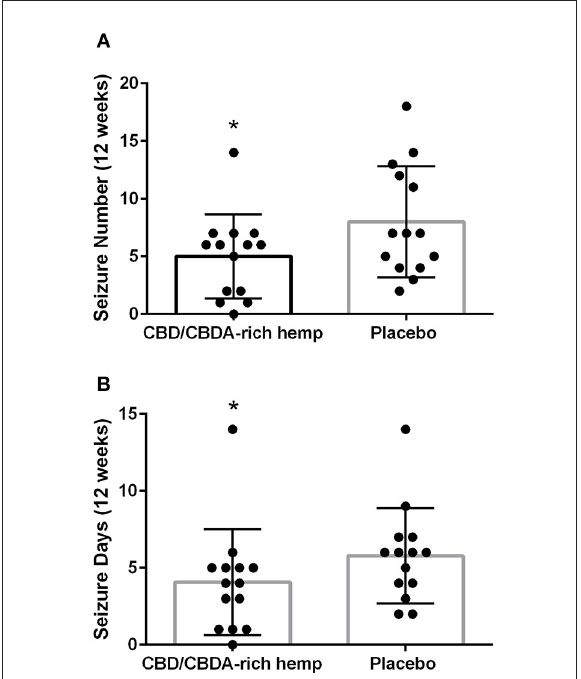
FIGURE2 Mean seizure activity over 12-weeks of CBD/CBDA-rich hemp oil vs. placebo compared to placebo. (A) Epileptic seizure numbers recorded by owners during treatment using an encapsulated CBD/CBDA-rich hemp oil (2 mg/kg every 12h) vs. placebo treatment. Asterisk indicates a significant difference ( P = 0.02). (B) Total days of seizure activity over the 12 week period using an encapsulated CBD/CBDA-rich hemp oil vs. placebo treatment. Asterisk indicates a significant difference ( P =